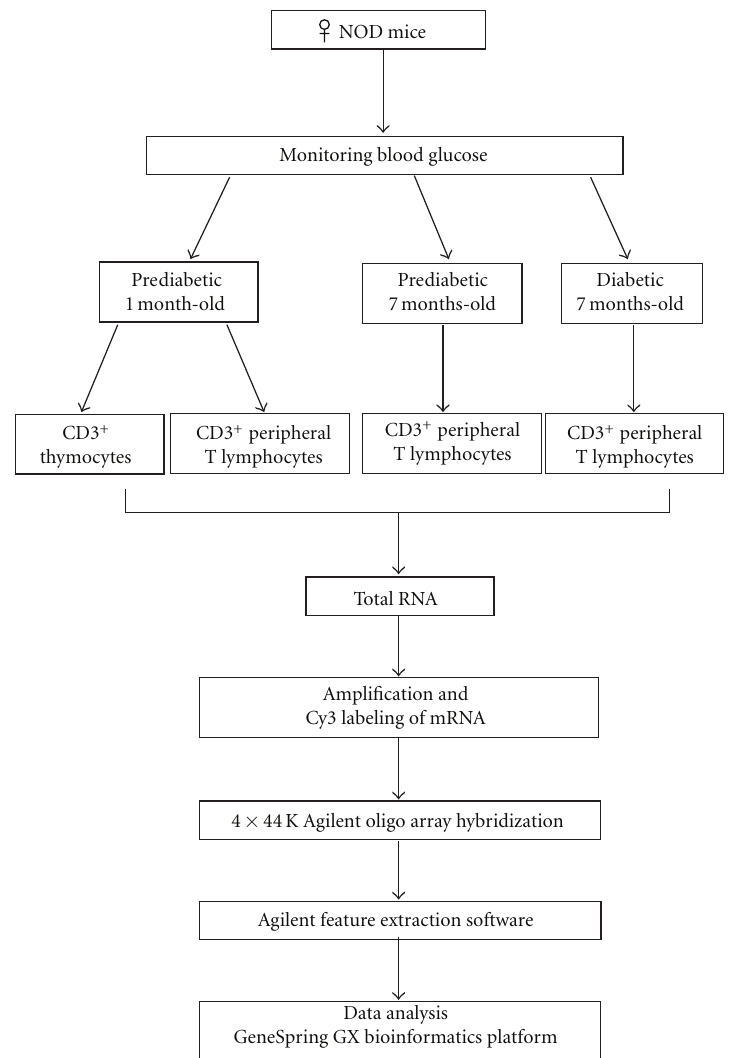
Figure 2: Experimental design of the work discriminating the biological samples used (animal groups and cell types), total RNA extraction, hybridizations, and microarray data